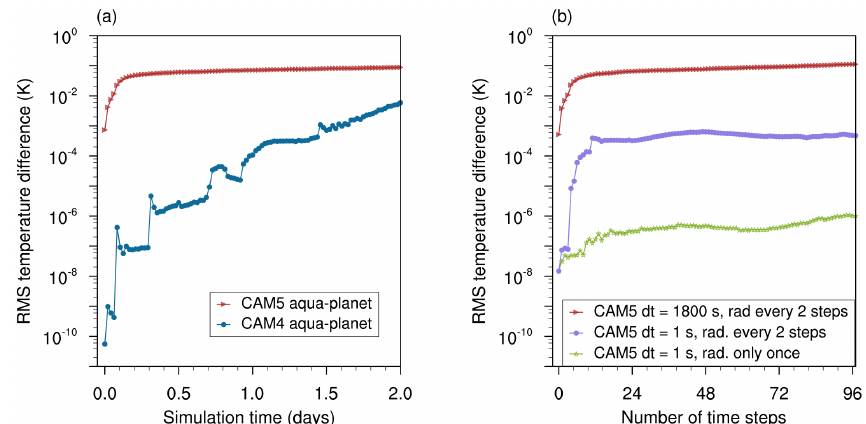
Figure 1. Examples of the evolution of root mean square (rms) temperature difference (unit:K) caused by random perturbations of the order of 10 − 14 K imposed on the temperature initial conditions. (a) Aqua-planet simulations conducted with the CAM4 (blue) and CAM5.3 (red) physics parameterization suites using the default 1800s time step. (b) Simulations conducted with the CAM5.3 physics suite using the default 1800s time step and with radiation calculated every other step (red), using a 1s time step and with radiation calculated every other step (purple), and using a 1s time step and with radiation calculated only once at the beginning of the integration. All simulations used the spectral element dynamical core at approximately 1 ◦ horizontal